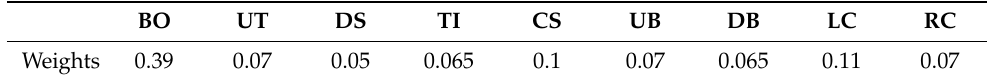
Table 7. Weights of barriers.